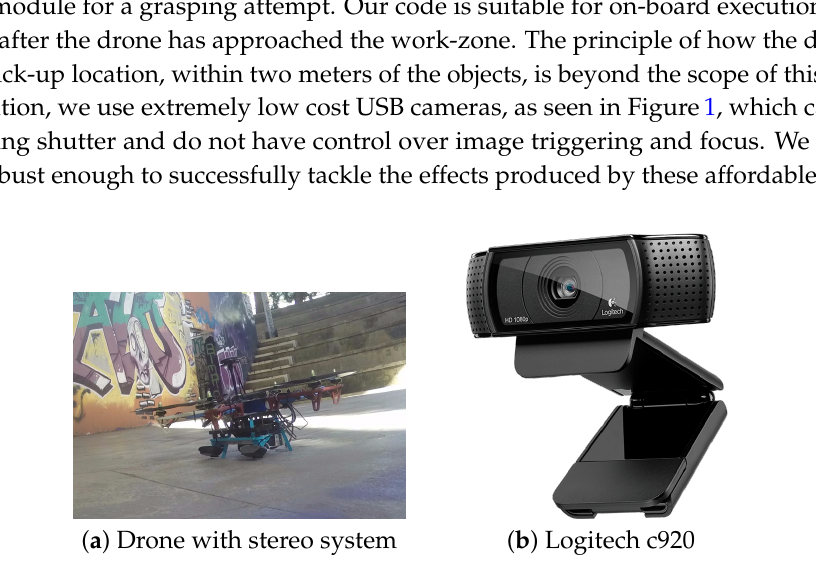
Figure 1. The UAV ( a ) used in the experiments with a stereo system comprised of low cost cameras; ( b ) More information about the system is shown is